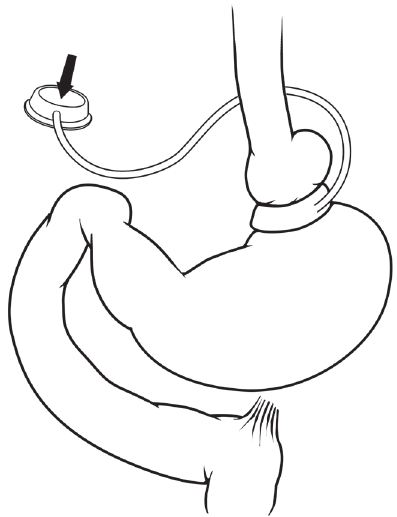
Figure 1. Adjustable gastric banding. In this procedure, an external ring is placed around the proximal portion of the stomach and has a balloon that lines the inside portion of the ring. The inflatable balloon is connected to a port in the subcutaneous tissue of the abdomen that allows the balloon volume, and therefore the amount of gastric restriction, to be adjusted.